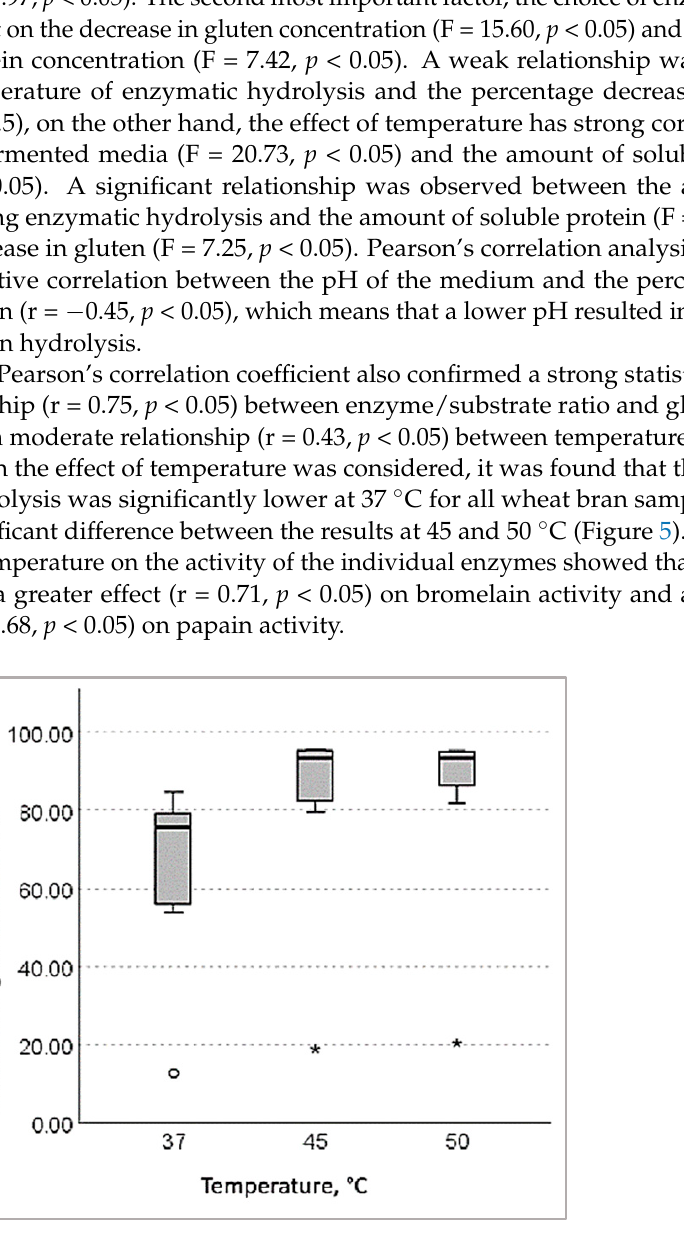
Figure 5. Reduction of gluten content in wheat bran samples after hydrolysis at different temperatures (The “ ◦ ” and “*”marks indicate the median of the decrease of gluten content values for the bran control samples. The * marks indicate that the difference between the median values of the control sample and the enzyme-treated samples is statistically significant ( p < 0.05)).